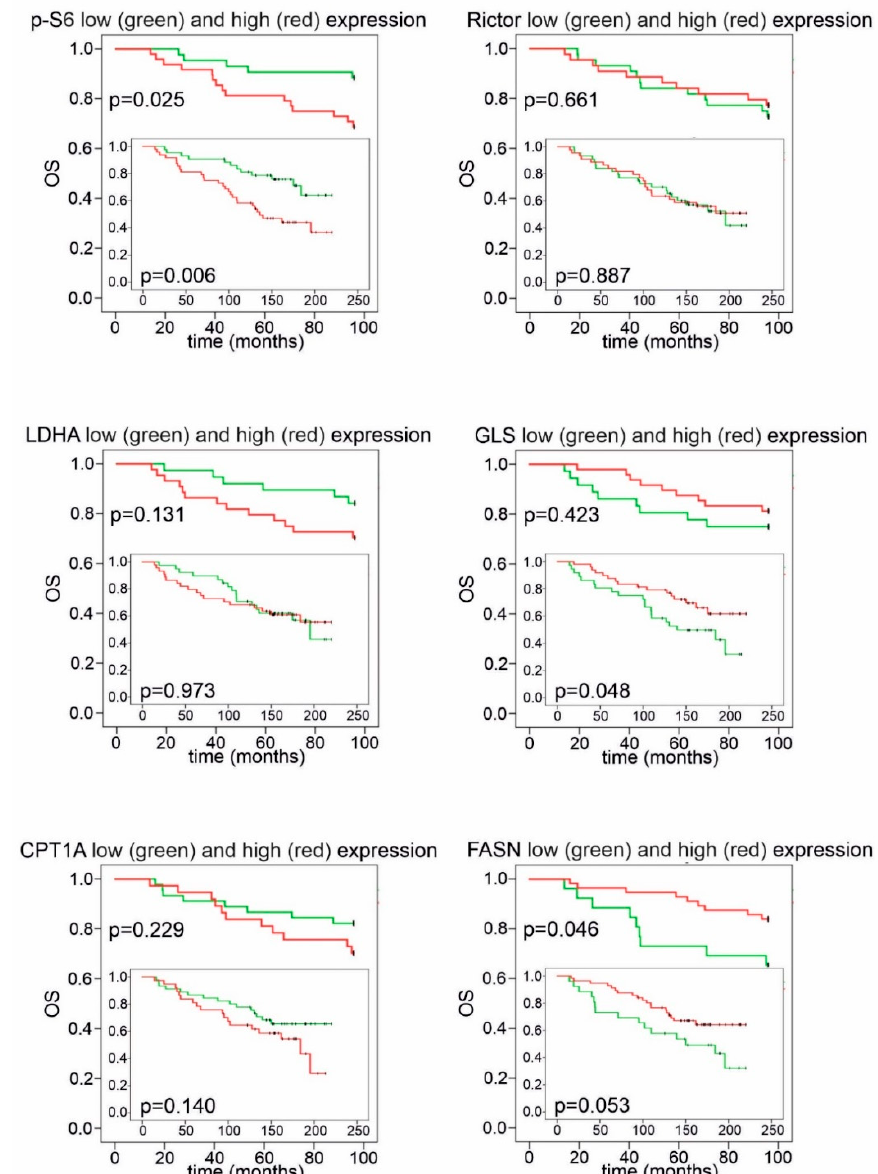
Figure 7. Kaplan–Meier analysis of overall survival in patient groups with high and low IHC scores. High p -S6 scores showed a correlation with worse overall survival (OS) during the whole follow-up period. Patients with high GLS scores had better OS, which reached statistical significance during long-term follow-up. High FASN scores indicated significantly better OS in the first 96 months; as for CPT1A, a tendency for worse survival was observed in the group with high H-scores. Low and high groups were determined based on median H-scores. The cut-off value was 150 for p -S6, LDHA, GLS and Rictor and 200 for FASN and CPT1A expression. Long-term (>200 months) follow-up data are displayed on insets.